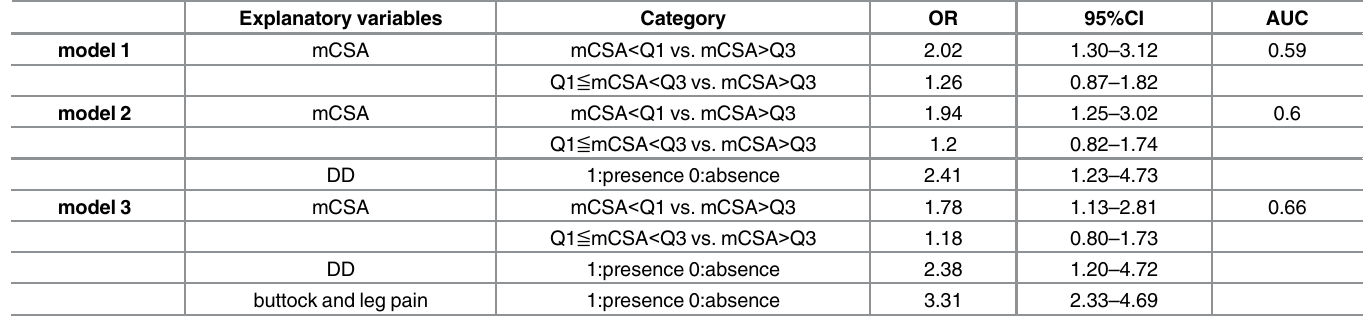
Table 3. Association between low back pain and the minimum cross-sectional area in each logistic regression model.